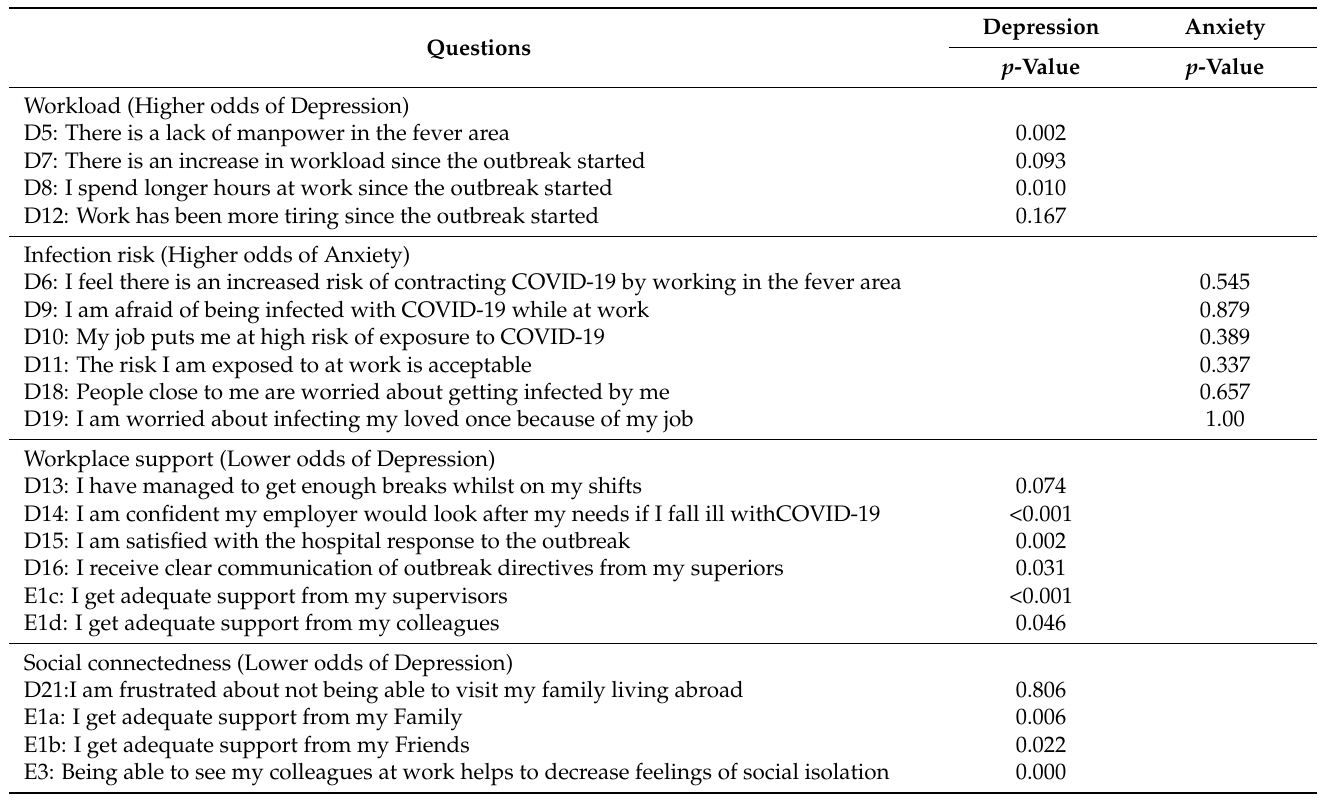
Table A2. Association between individual questions in ‘Workload’, ‘Infection risk’, ‘Workplace support’ and ‘Social connectedness’ categories with the relevant MHOs (univariate analysis).